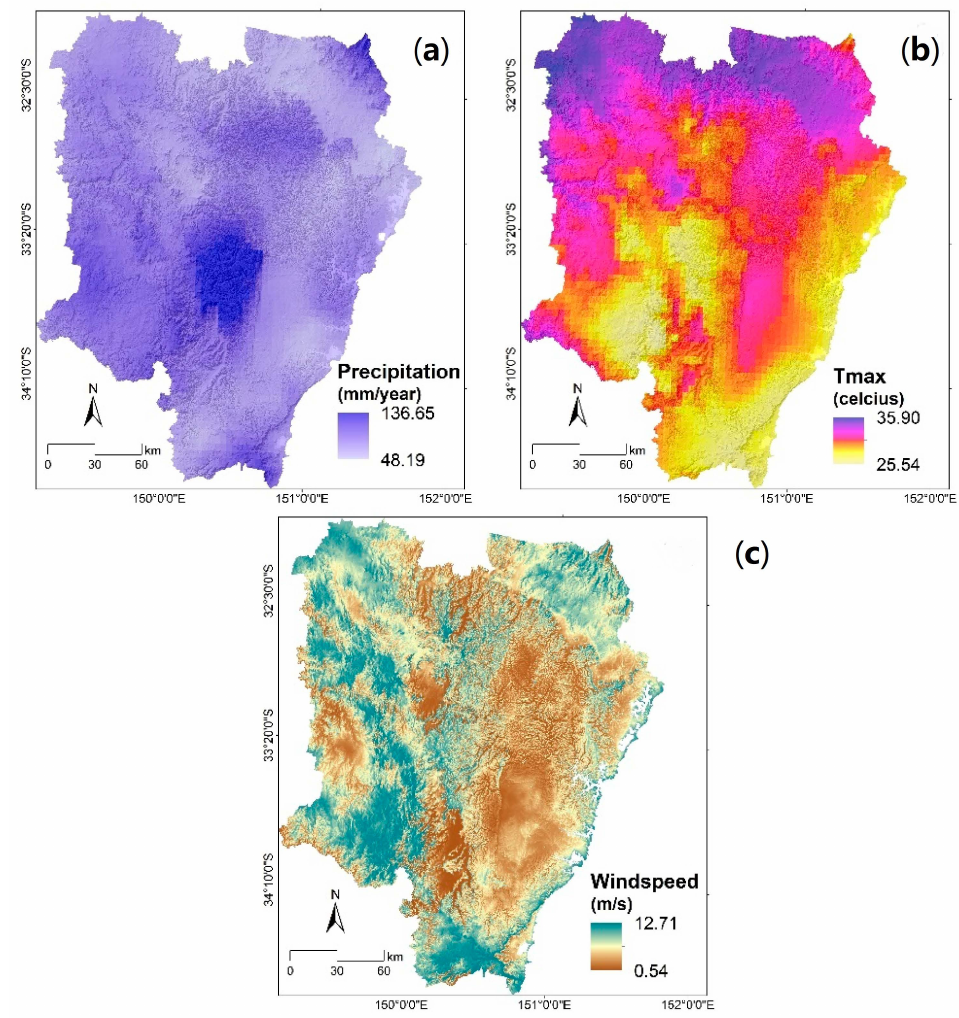
Figure 4. Meteorological-related factors: ( a ) precipitation, ( b ) maximum temperature, and ( c )